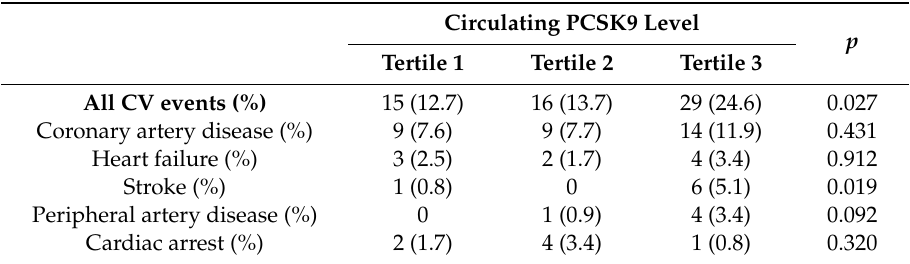
Table 3. Incidence of CV events based on plasma PCSK9 level.